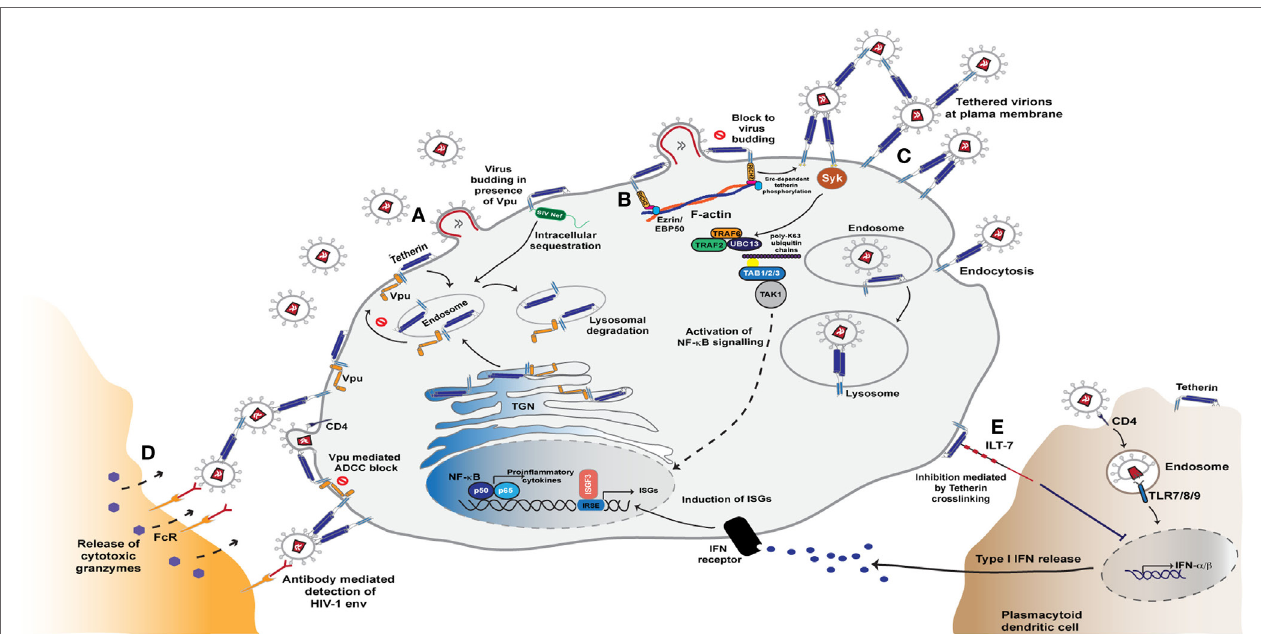
FigURe 3 | Tetherin mediated restriction of HIV-1 assembly and release. (A) Tetherin resides in the plasma membrane and is constitutively recycled from the plasma membrane via endosomes and the trans-Golgi network (TGN). The antiviral activity of tetherin is counteracted by the Vpu and Nef proteins. During HIV-1 infection, Vpu binds to the transmembrane domain of tetherin in the endoplasmic reticulum and Golgi network and sequesters it in endosomal regions in a clathrin-dependent manner. This rerouting of tetherin from the plasma membrane leads to its degradation in lysosomes via the ESCRT pathway. SIV Nef, too, is able to antagonise tetherin activity by sequestering tetherin from the sites of virus assembly, leading to lysosomal degradation of the entrapped molecules. (B) In the absence of Vpu and Nef activity, tetherin accumulates at virus assembly sites and blocks virus release from the plasma membrane. This clustering of retained virions triggers a signalling cascade mediated by tetherin’s cytoplasmic tail that leads to NF- κ B activation and release of proinflammatory cytokines. This sensing of retention is reliant on tetherin association with the actin cytoskeleton via the adaptor protein RICH2. (C) Signalling that ultimately leads to NF- κ B activation triggered by